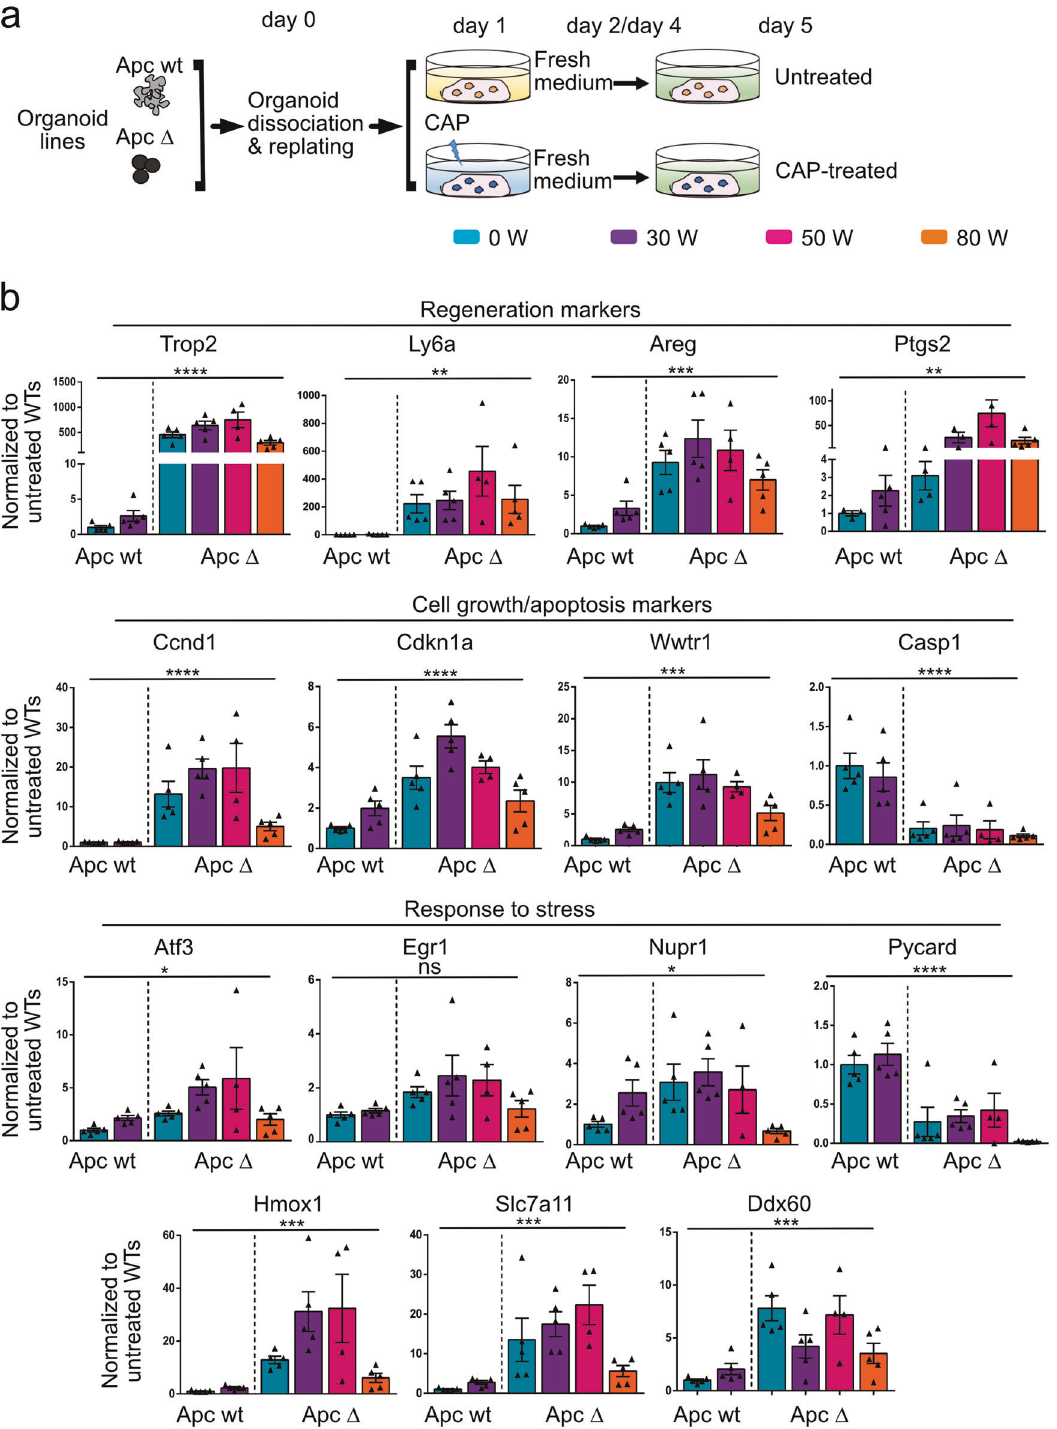
Fig. 7 Apc-de fi cient-derived organoids exhibit increased resistance to CAP treatment as compared to normal intestinal stem cell-derived organoids. a Design of the experiment. See fi gure legend Fig. 6a. b Gene expression analysis by qRT-PCR of the indicated markers involved in regeneration, cell growth/apoptosis and response to stress. Each symbol corresponds to a given organoid line. Values are normalized to Untreated Apc wt levels. Data are represented as means ± sem. One-way ANOVA test. **** P < 0.0001; *** P < 0.001; ** P < 0.01; P < 0.05; ns: not signi fi